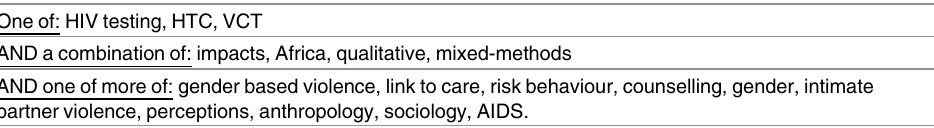
Table 1. List of